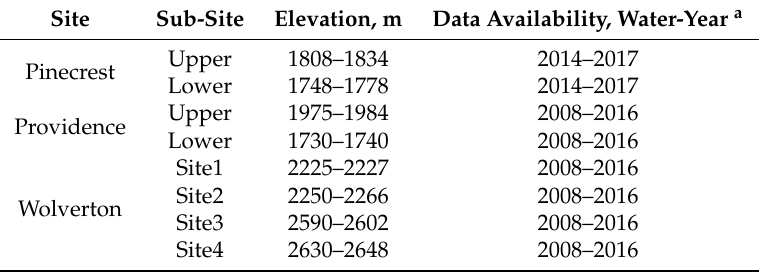
Figure 1. ( a ) The study areas locations in the Sierra Nevada of California. Snow-depth sensor locations around the ( b ) lower met stations and ( c ) upper met stations in the Providence site. Table 1. Elevation information of each site and time-series data